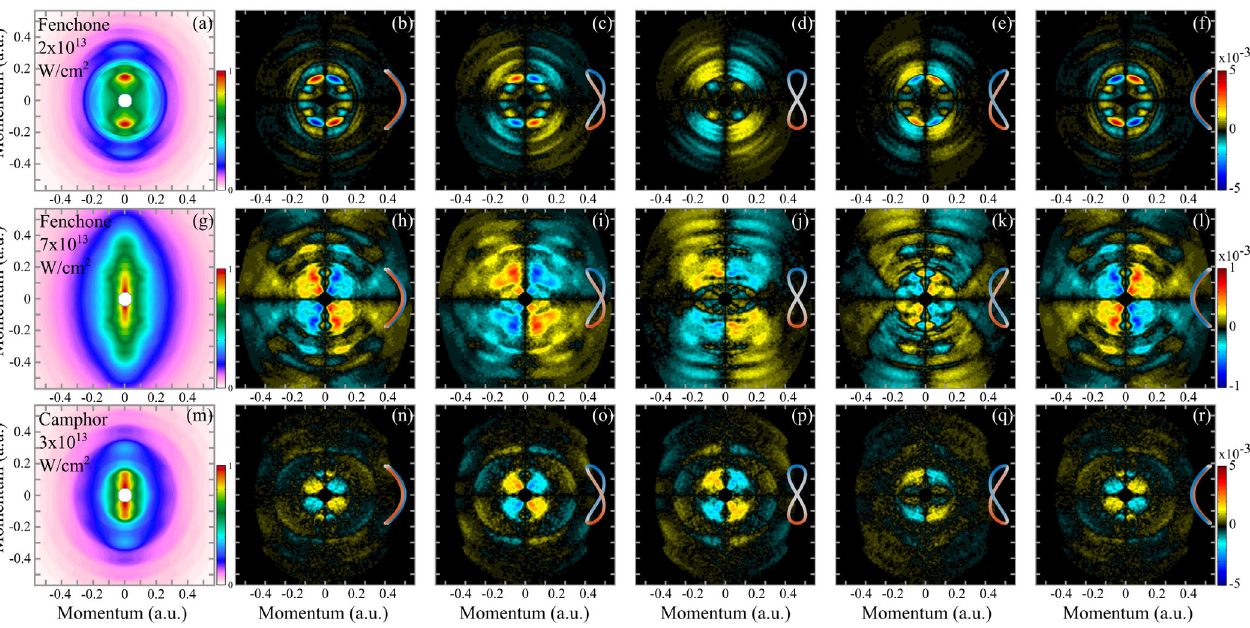
FIG. 4. Experimental data. (a),(g),(m) Normalized projections in the y - z plane of the photoelectron angular distribution for (a) fenchone ðþÞ with a fundamental field of 2 × 10 13 W cm − 2 , (g) fenchone ðþÞ at 7 × 10 13 W cm − 2 , and (m) camphor ðþÞ at 3 × 10 13 W cm − 2 . The Keldysh parameter in these datasets is γ ¼ 1 . 5 (a),(m) and γ ¼ 0 . 8 (g). (b) – (f),(h) – (l),(n) – (r) Evolution of the ESCARGOT signal as a function of the relative phase φ between the two components of the ionizing field ( φ ¼ 0 , π = 4 , π = 2 , 3 π = 4 , and π from left to right). The shape of the two-color field, colored according to the instantaneous chirality, is shown next to each image. The ESCARGOT signal is normalized to the maximum of the photoelectron spectrum in (a),(g),(m). The data are presented after up-down antisymmetrization (see Sec.